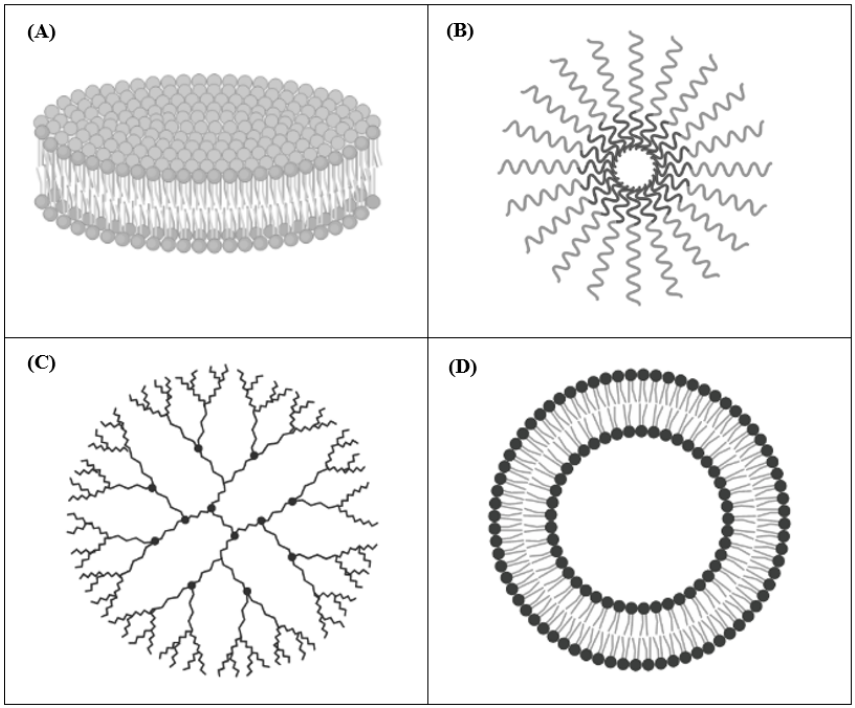
Figure 1. Generic structure of nanodisks ( A ), polymeric micelles ( B ), dendrimers ( C ), and liposomes ( D ).